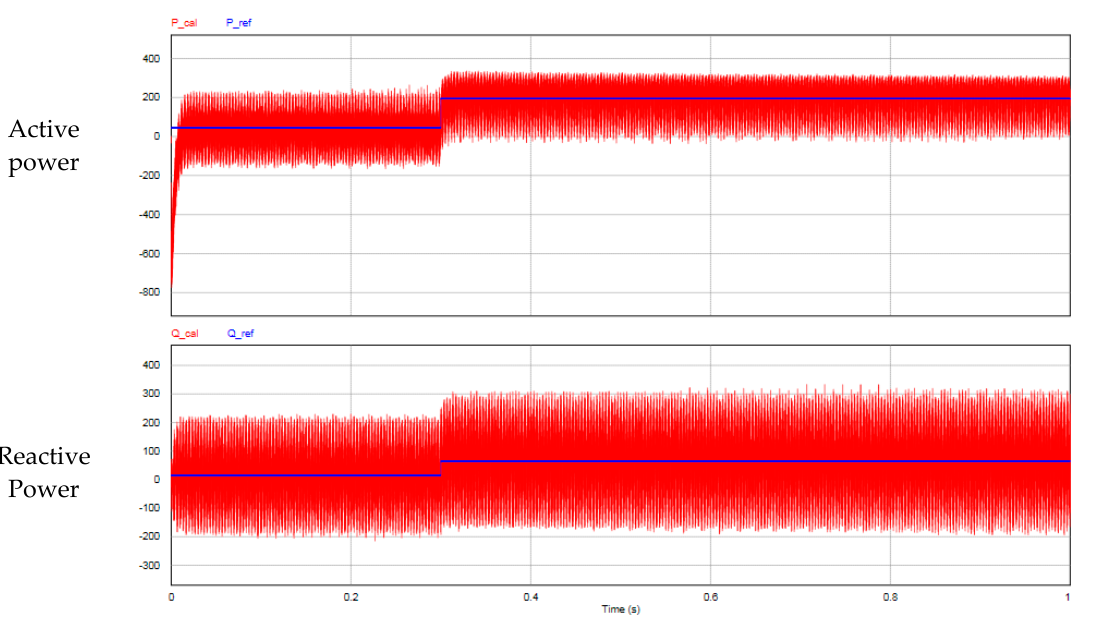
Figure 19. Active and reactive power (reference vs. calculated).